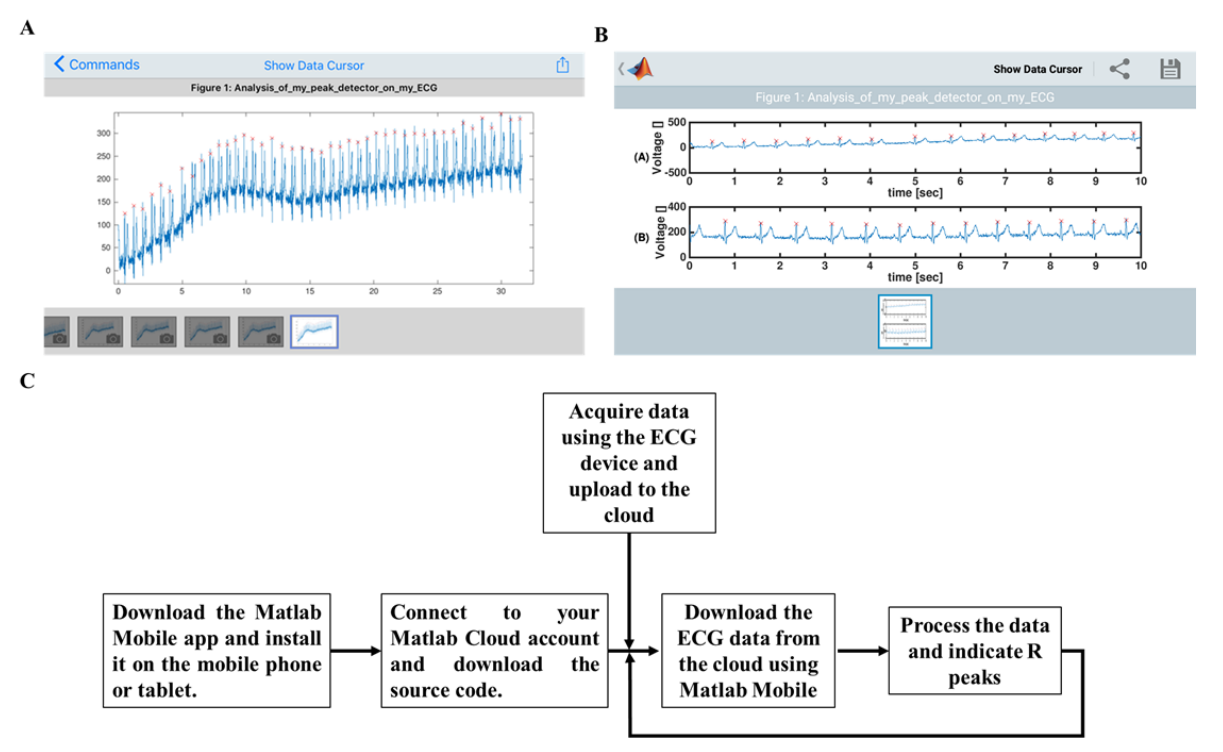
Our algorithmBehar et al algorithmPan et al algorithmgqrs algorithmStatistic